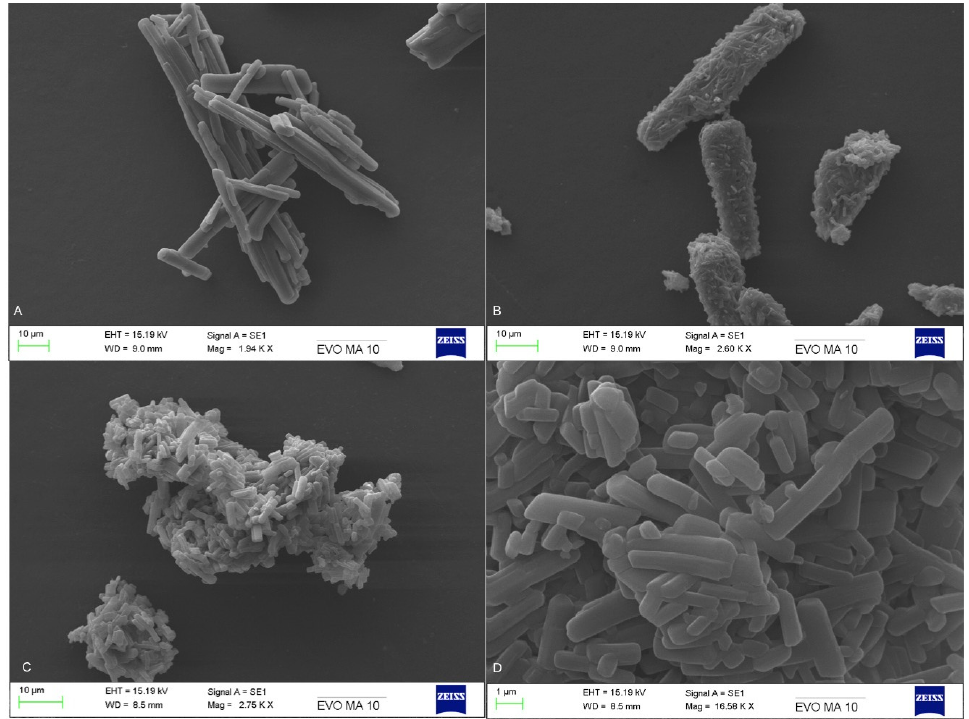
Figure 2. SEM analysis of ( a ) bulk THL, ( b ) THL-NIC physical mixture, ( c ) THL-NIC cocrystals at 2.75 kX magnification, ( d ) THL-NIC cocrystals at 16. 58 kX